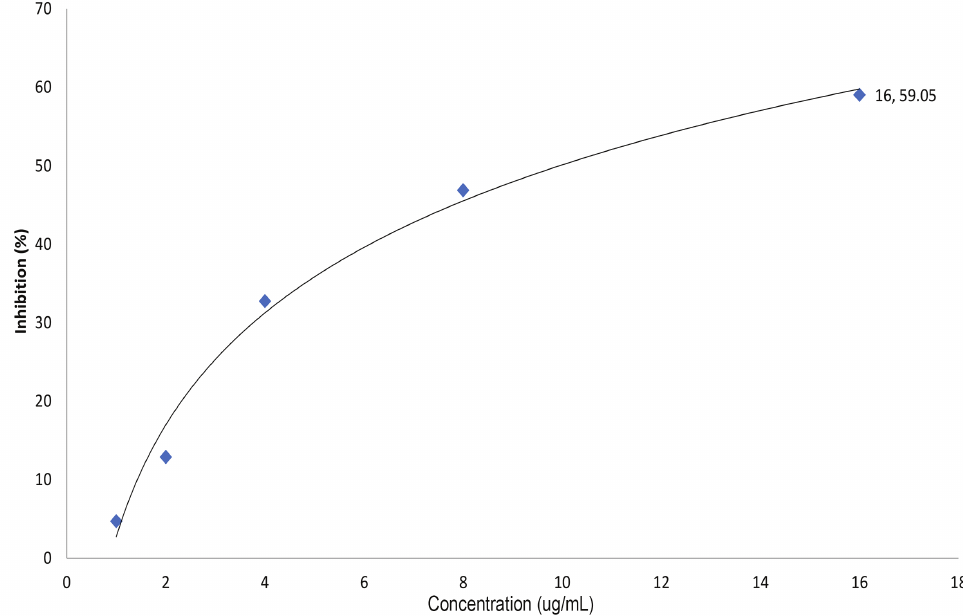
FIGURE 7 - Curve of tyrosinase inhibitory activity of the kojic acid. TABLE IV - Tyrosinase inhibitory activity of IL-MAE extract Concentration of samples